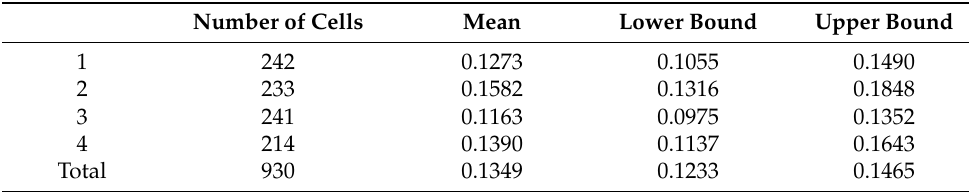
Table 1. Summary of 5-mC levels measured in the genomic DNA of Astyanax scabripinnis. Individuals 1 and 2 are male B + and B − , respectively. Individuals 3 and 4 are females, B + and B − , respectively. Confidence interval for mean: p > 95%.